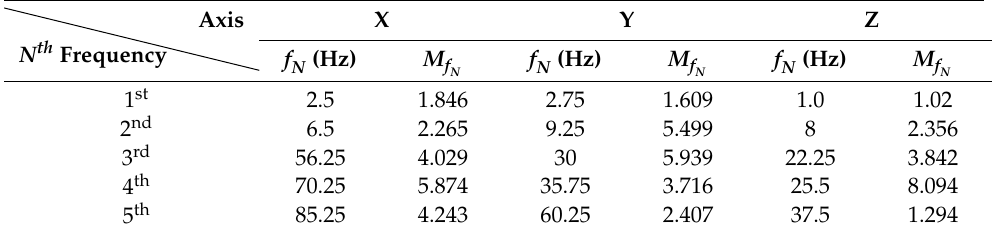
(cid:16) (cid:17) M f in transmissibility. N